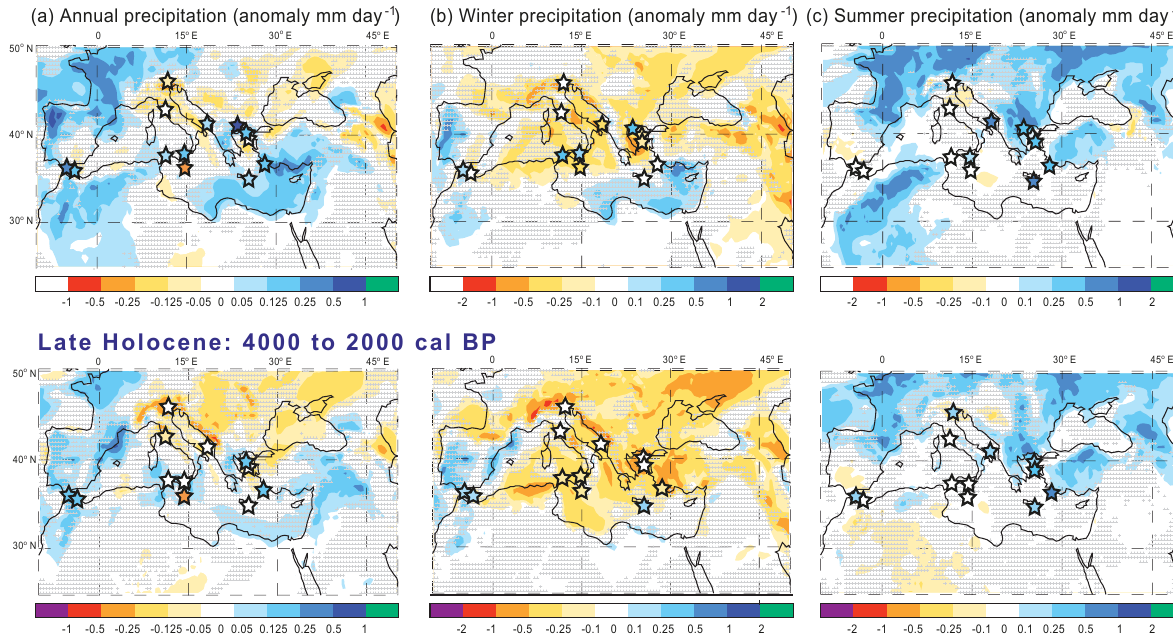
Figure 3. Data–model comparison for mid- and late-Holocene precipitation, expressed in anomaly compared to the present day (mmday − 1 ). Simulations are based on a regional model (Brayshaw et al., 2010): standard model HadAM3 coupled to HadSM3 (dynamical model) and HadRM3 (high-resolution regional model). The hatching representing statistical significance refers to the anomalies shown on the same plot, i.e., the difference between the experiment (either 8000–6000 or 4000–2000) and the present-day control run. The hatched areas indicate areas where the changes are not significant (significance level of 0.30). Pollen-inferred climate estimates (stars) are the same as in Fig. 2: annual precipitation, winter precipitation (winter is the sum of December, January, and February precipitation), and summer precipitation (summer is the sum of June, July, and August